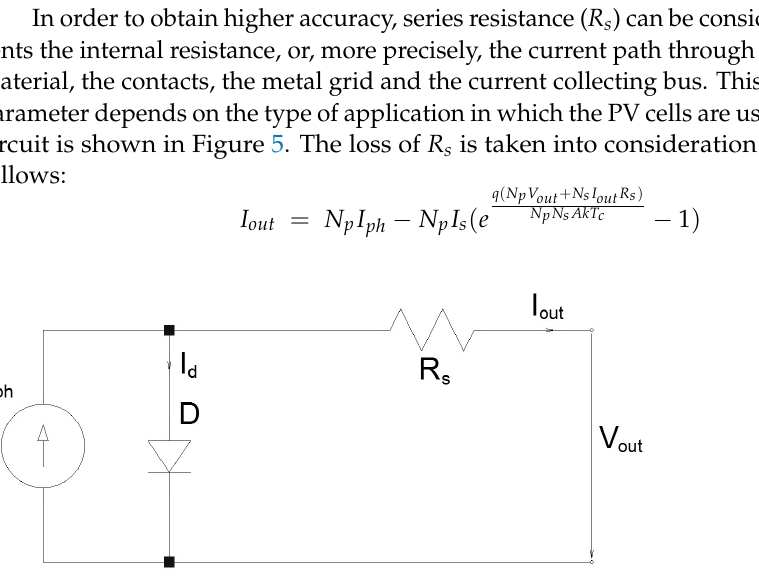
Figure 5. Equivalent circuit of simplified PV simulation model.